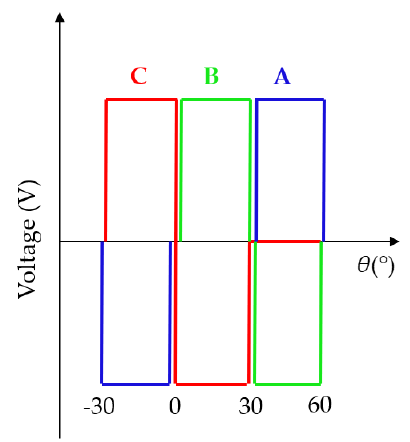
Figure 5. Commutation pattern of three-phase SRM